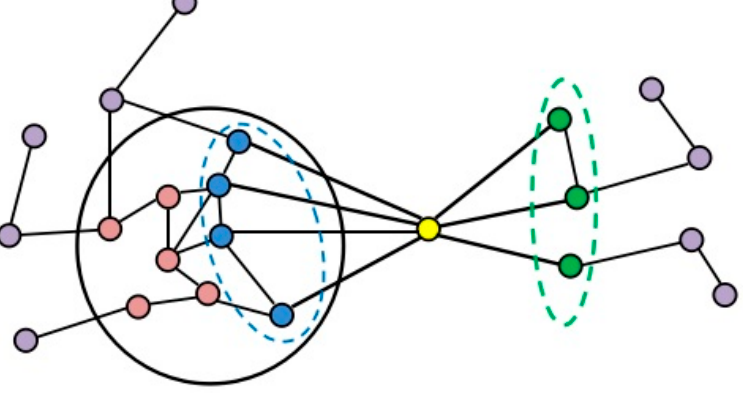
Figure 2. A formation process of attachment: these proteins inside the black circle constitute a complex core; the yellow protein represents a candidate neighbor protein of complex core; the blue proteins represent neighbors inside core; the green proteins represent neighbors outside core.